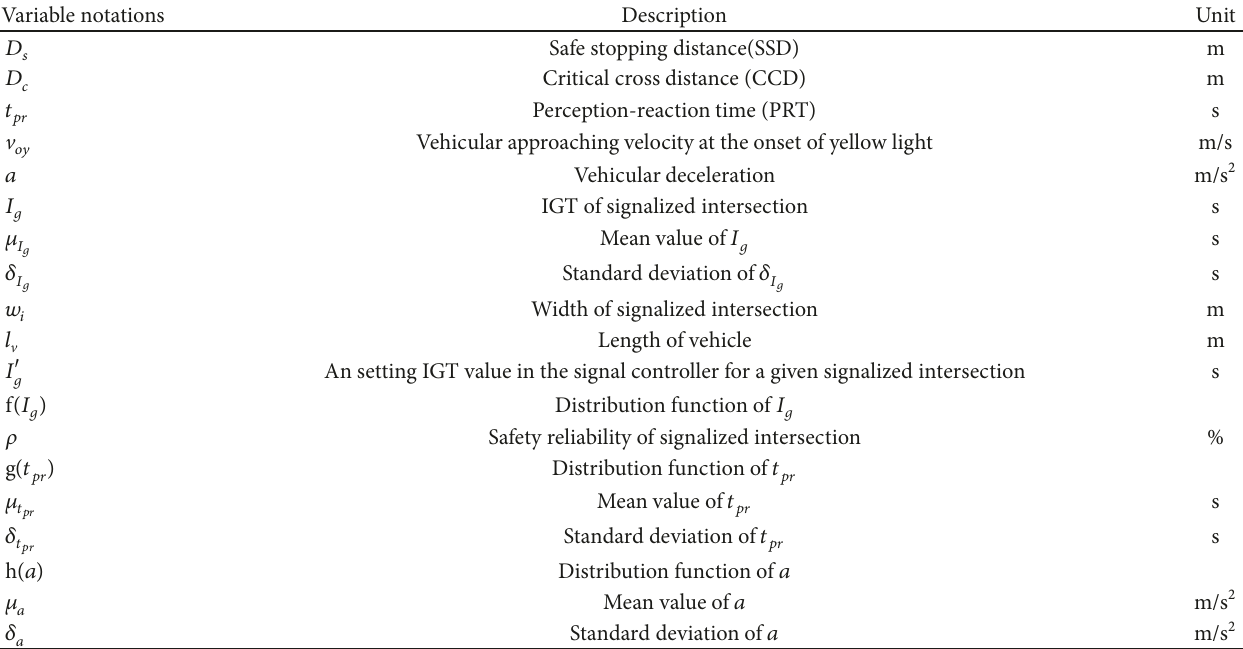
Table 1: Variable notations in this